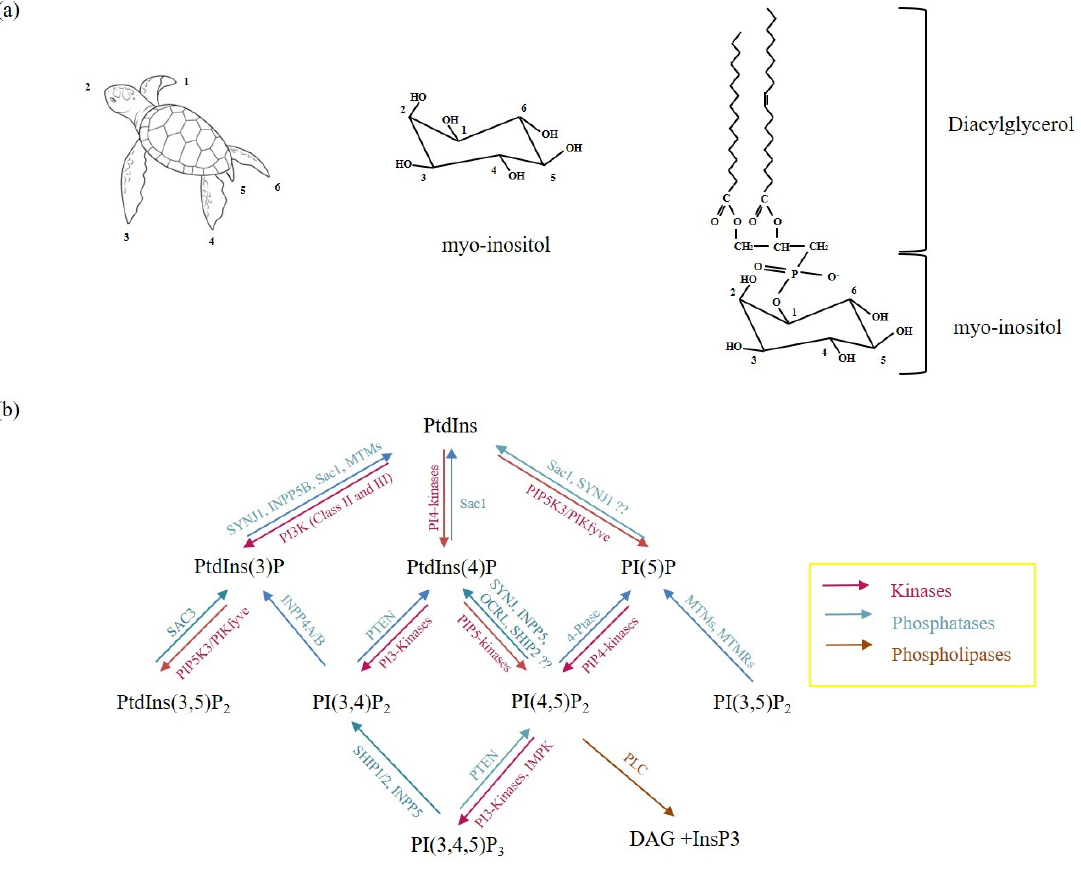
Figure 1. Phosphoinositides and their metabolic enzymes in the Phosphoinositide (PI) cycle. ( a ): Schematic diagram showing the positions of the individual hydroxyl groups in myo–inositol following Agranoff’s turtle concept. ( b ): metabolism of phosphoinositides depends on several lipases, phosphatases and kinases to catalyze PI-dependent reactions. ?? represents enzymatic reactions that are not completely understood.